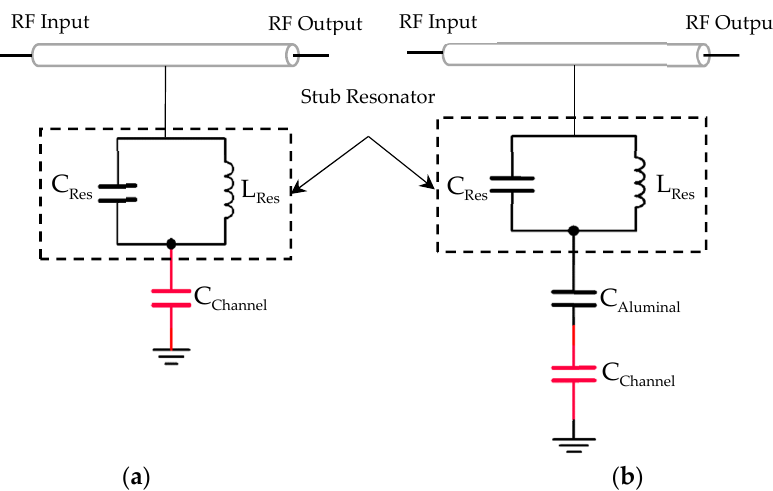
Figure 3. Electrical equivalent model of ( a ) our proposed biosensor with via on the tip of stub; ( b ) sensor without